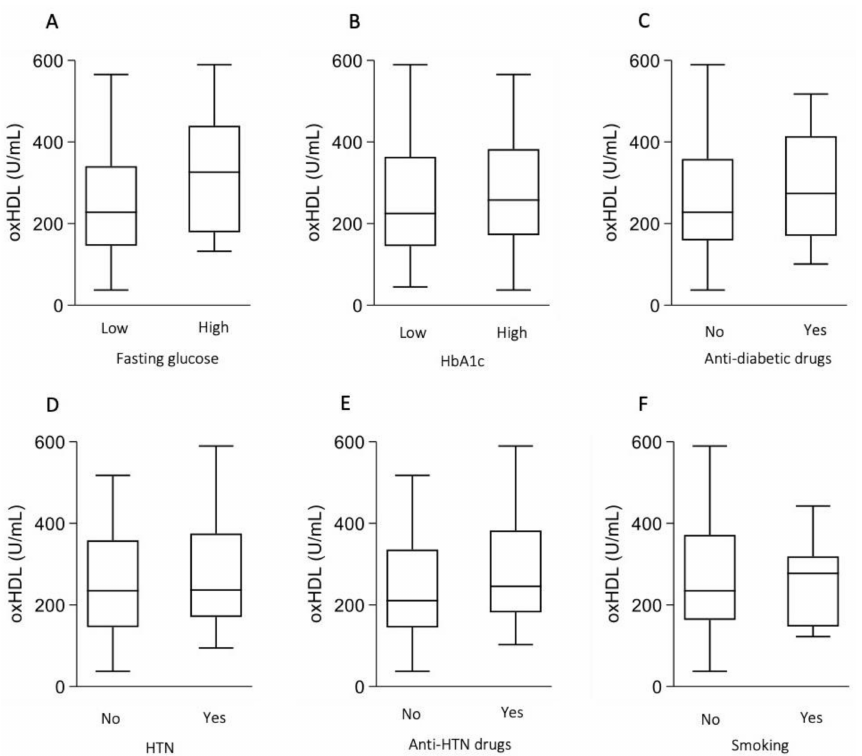
Figure 3. oxHDL levels in each group among patients with NAFLD. ( A ) Low fasting glucose (<126 mg/dL, n = 79) versus high fasting glucose concentration ( ≥ 126 mg/dL, n = 27). ( B ) Low HbA1c (<6.5%, n = 71) versus high HbA1c ( ≥ 6.5%, n = 33). ( C ) Non-use ( n = 43) versus use of anti-diabetic drugs ( n = 63). ( D ) No hypertension (HTN) ( n = 43) versus hypertension (HTN) ( n = 63). ( E ) Non-use ( n = 57) and use of anti-HTN drugs ( n = 49). ( F ) Non-smoker ( n = 98) versus smoker ( n =